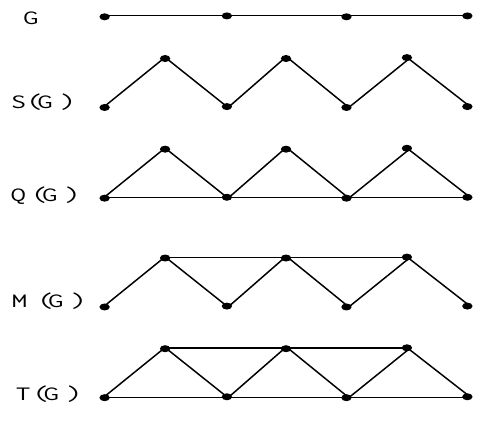
Fig. 2 The graphs G , S ( G ) , Q ( G ) , M ( G ) , T ( G )